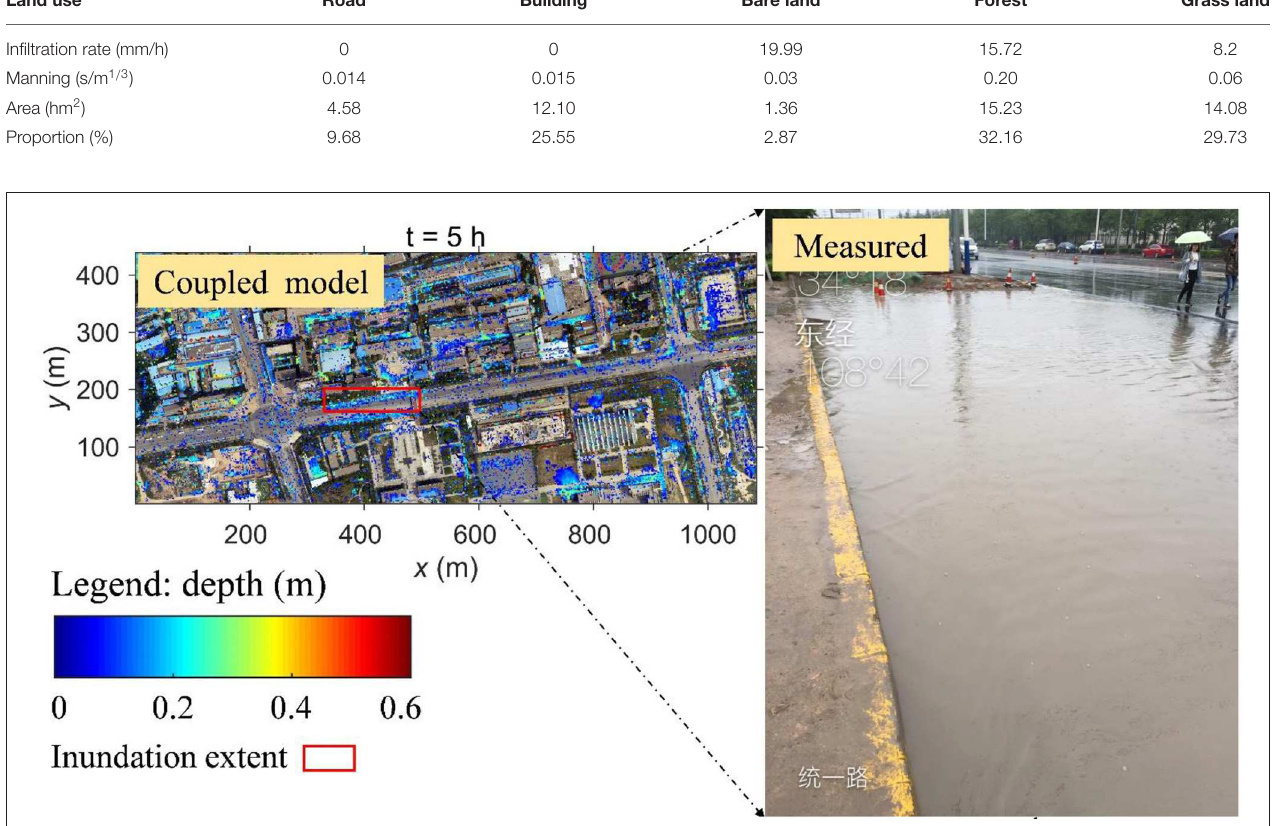
FIGURE 10 | The coupled model extent and observed, measured inundation extent in the study area (5th h).